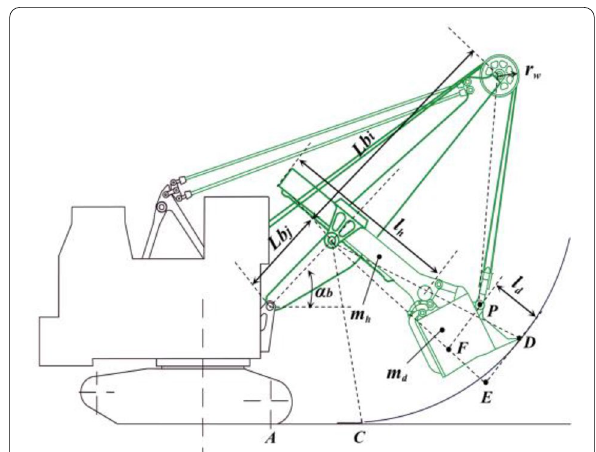
Figure 13 Explanatory diagram of the ECS prototype working device